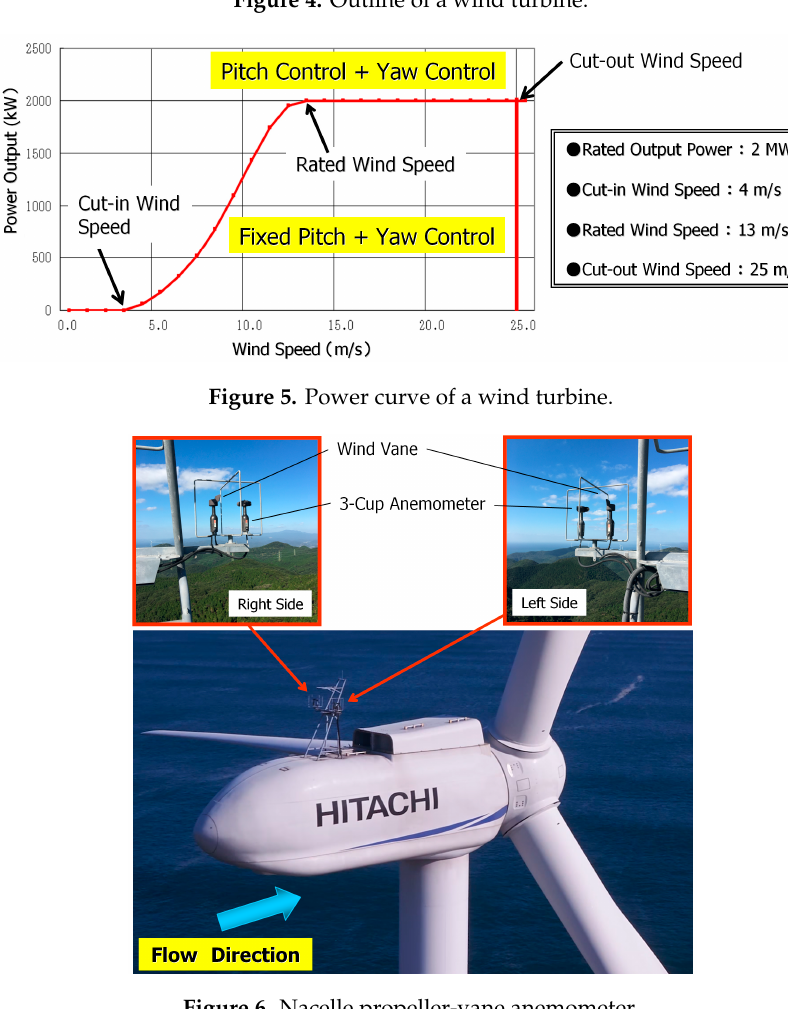
Figure 6. Nacelle propeller-vane anemometer.